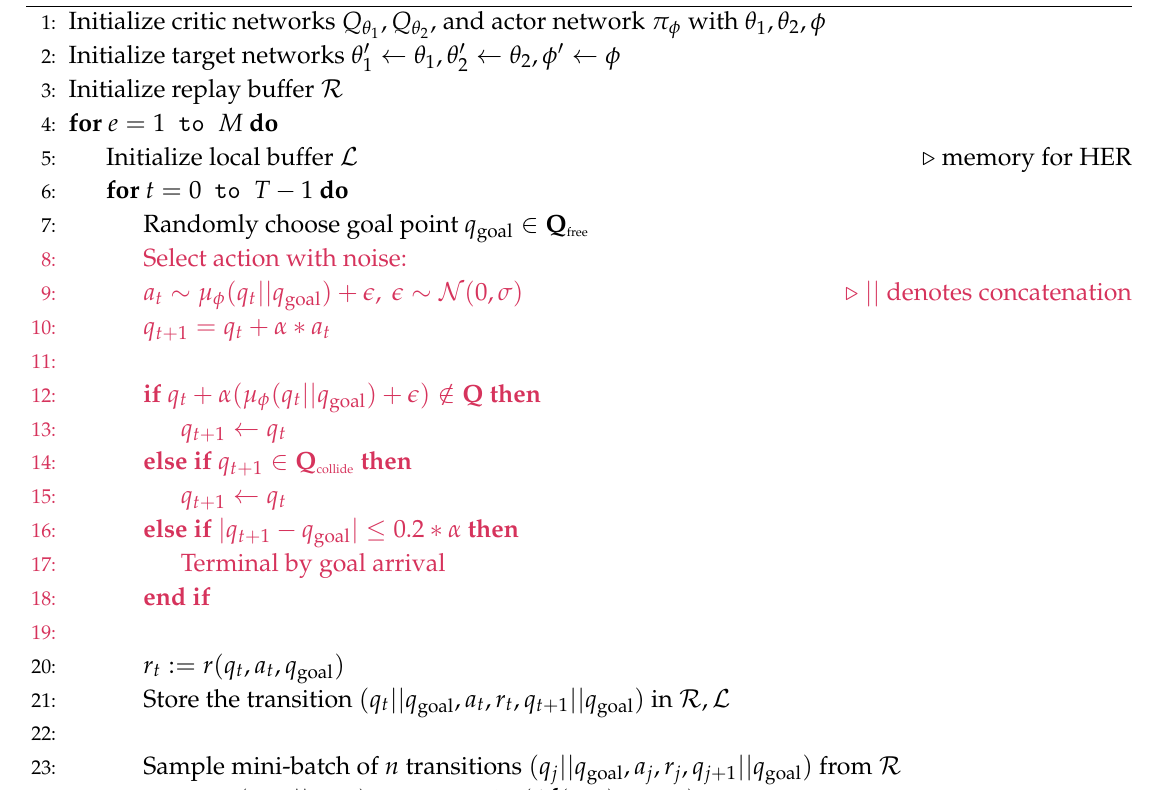
Algorithm 1 Training procedure for motion planning by TD3 with HER. The red part is for a robot manipulator, and the blue part is for